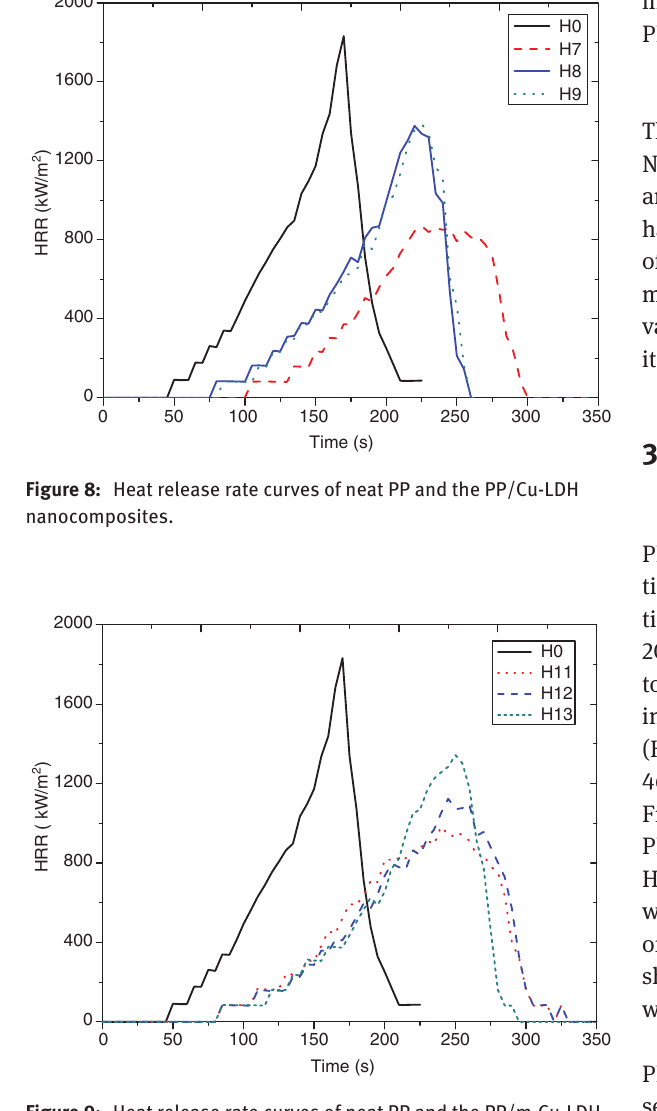
Table 5: Cone calorimetric data for the PP/Cu-LDH and PP/m.Cu-LDH nanocomposites. Parameter